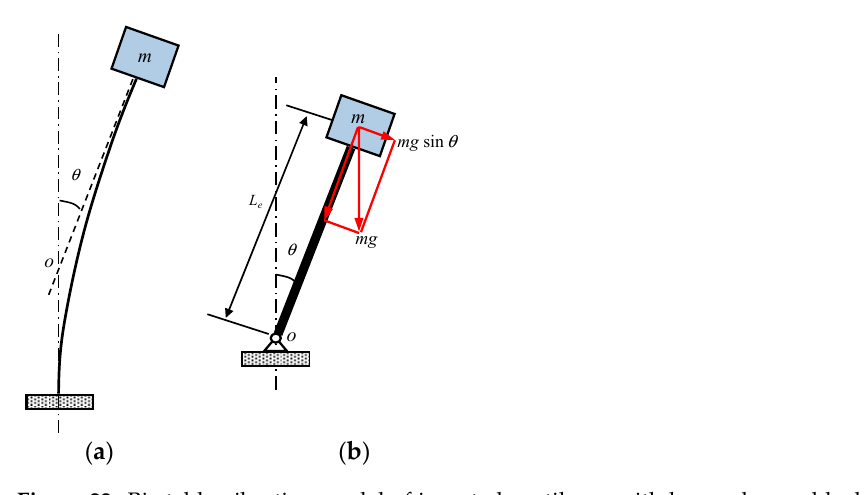
Figure 21. Results of comparing average electrical power with different amplitude.